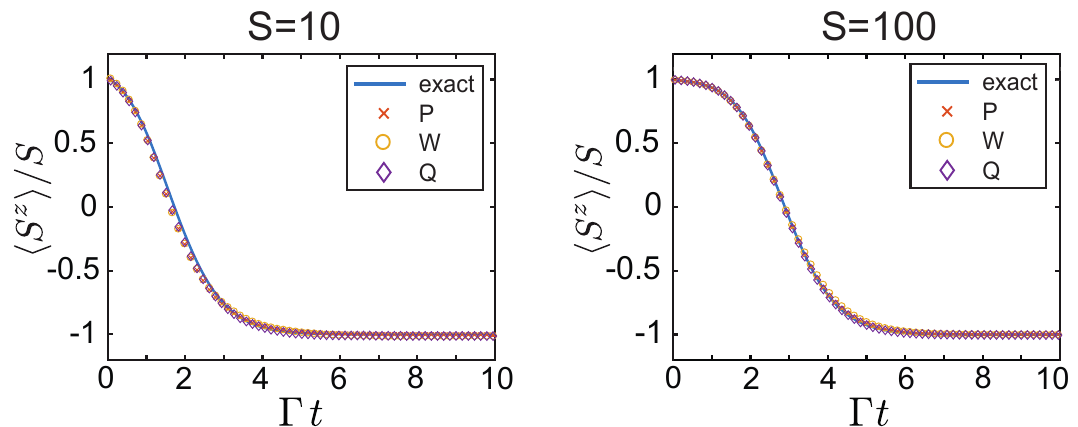
Figure 1: Simulation of the superradiant decay of a single collective spin with spin quantum number S = 10 and S = 100. The system is initially prepared in the high- est excited state, | S z = S 〉 . The stochastic simulations for the P -, Q - and Wigner- distribution are compared to the exact integration of the master equation, Eq.